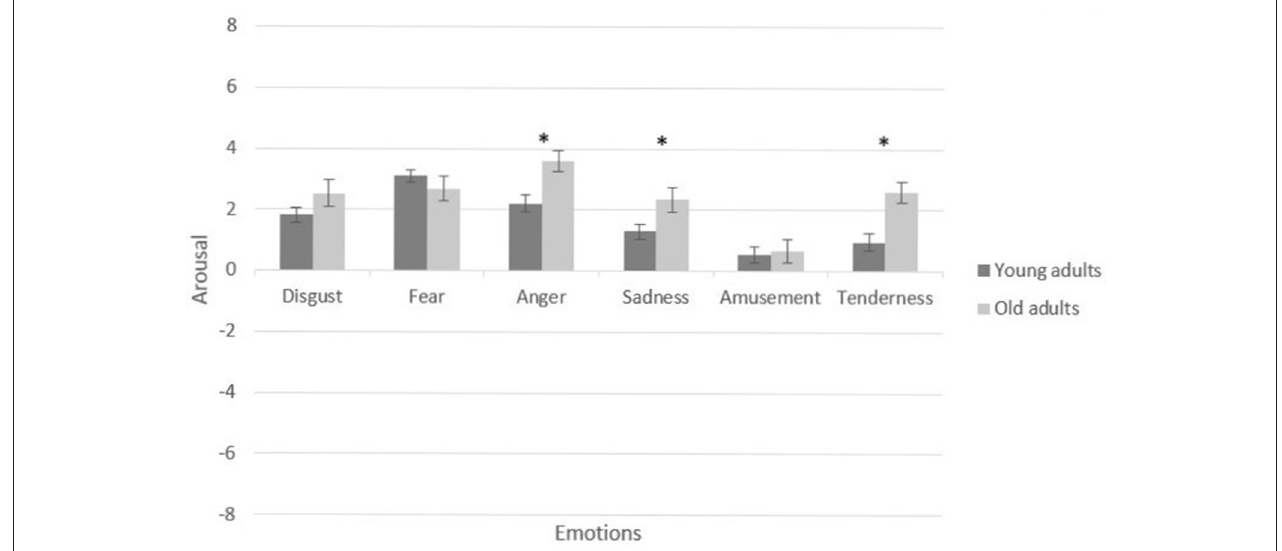
FIGURE 5 | Self-reported arousal of participants by film condition and age group. Participant-level means of differences between emotional targets scores and baseline categories. Error bars depict standard error (SE) values. * p <